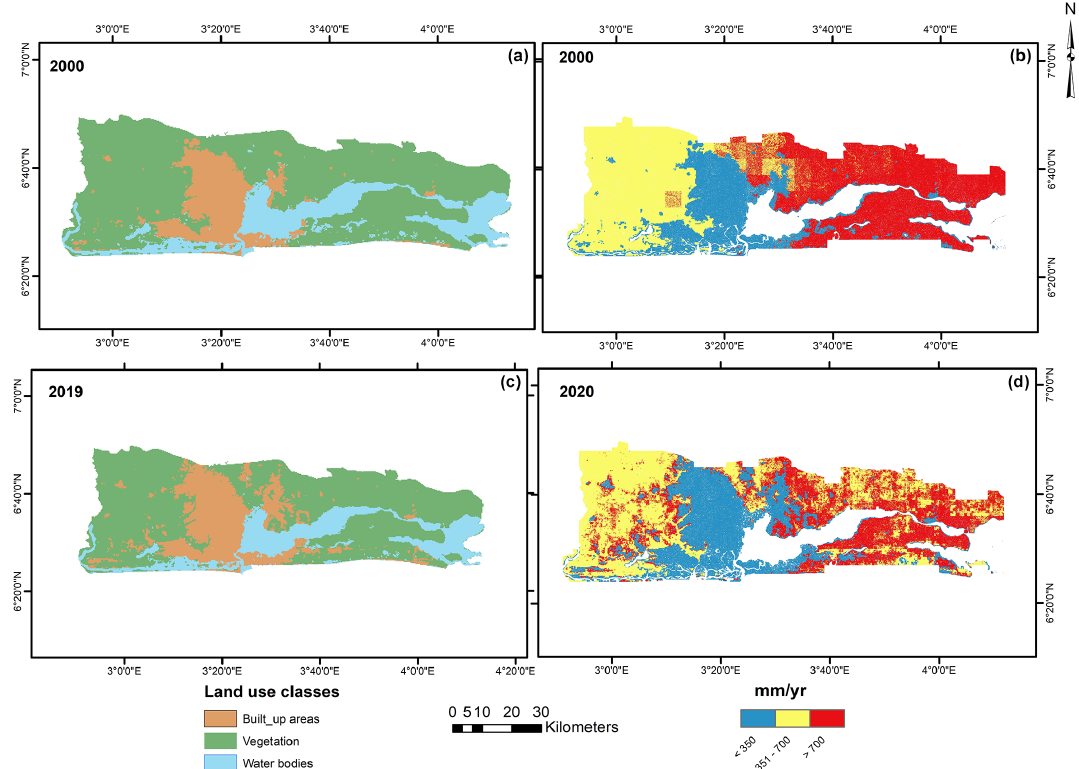
Figure 2. (a, c) Input Land use maps for 2000 and 2019 and (b, d) simulated recharge for 2000 and 2020 illustrating the rapid increase in urban surfaces at the expense of vegetated surfaces and general decrease of recharge as urban areas